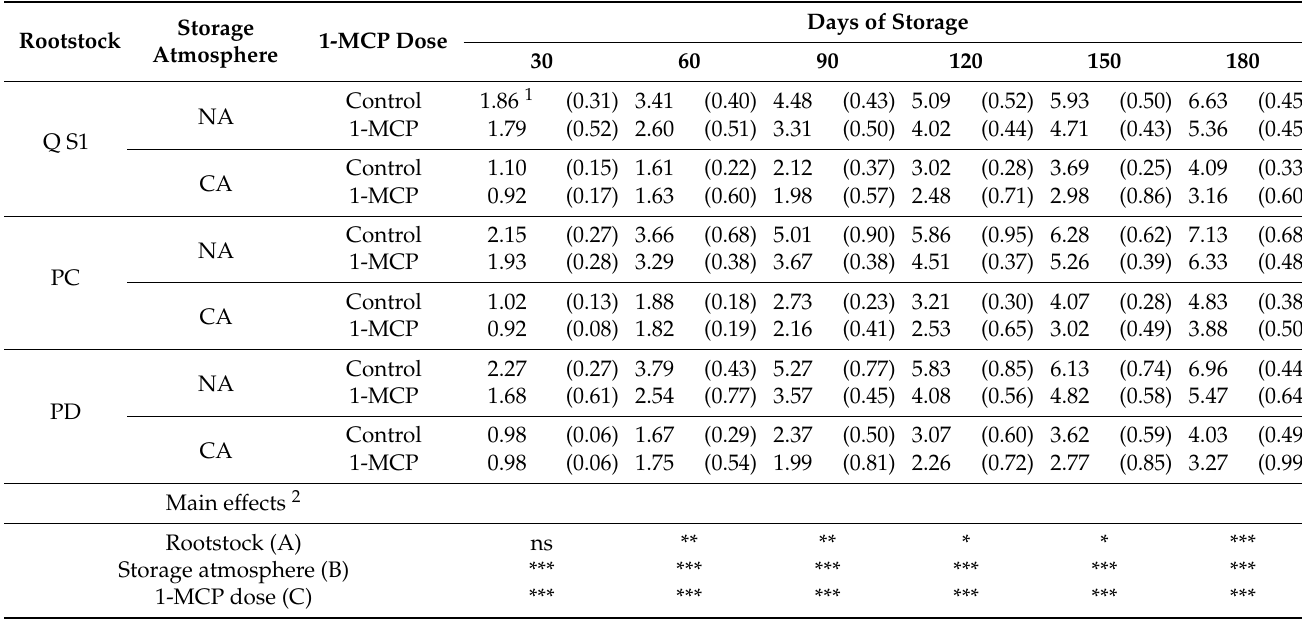
Table 4. Mass loss of non-1-MCP-treated (control) and of 1-MCP-treated ‘Conference’ pears after storage in normal (NA) and controlled (CA) atmosphere in